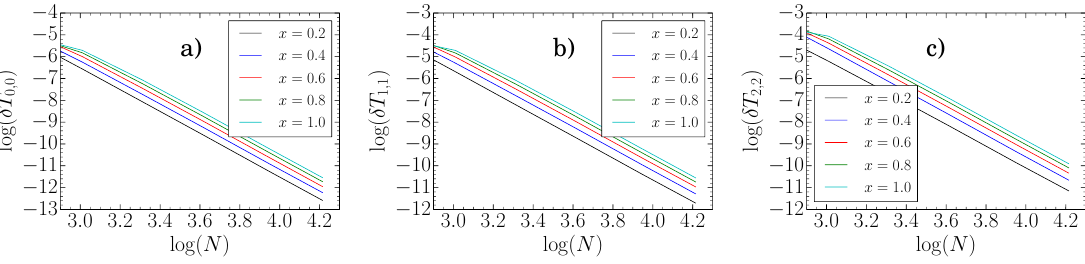
Figure 1. Regge–Wheeler for Schwarzschild: Convergence tests . Convergence rates of the numerical transmission probabilities T s , s ( x ) , (greybody factors), for ( a ) scalars, ( b ) photons, and ( c ) gravitons. Here, we have defined the relative error of the N -th approximation, (i.e. the N term approximation), (cid:12) ( N ) ( N + 1 ) ( x ) ( x ) (cid:12) (cid:12) / T ( N ) ( x ) T as δ T s , s (cid:12) T s , s s , s s , s ≡ −